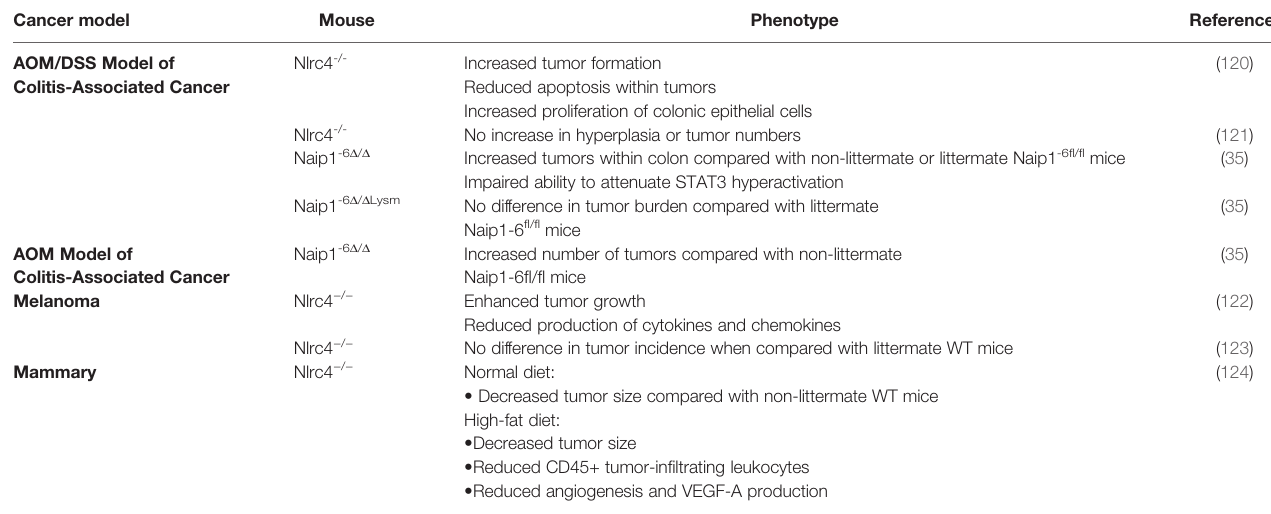
TABLE 1 | The role of NLRC4 in cancer using mouse